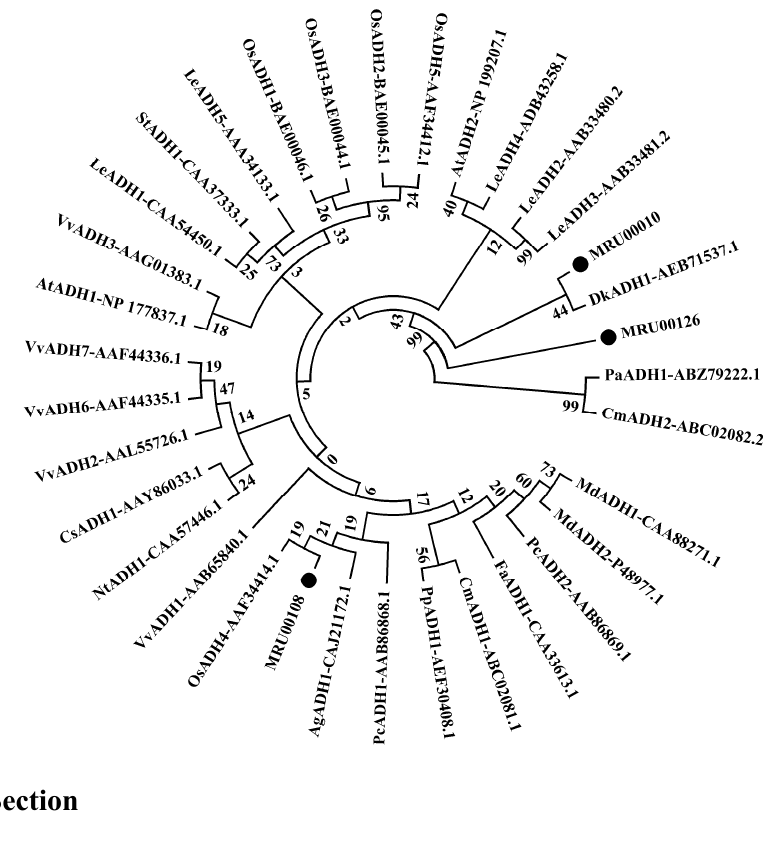
Figure 4. Alignment of alcohol dehydrogenase (ADH) gene family members of Chinese bayberry with other plant ADHs based on amino acid